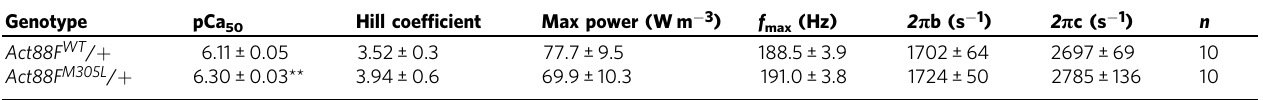
Table 2 Power measurements and muscle apparent rate constants determined from IFM mechanical analysis. Genotype